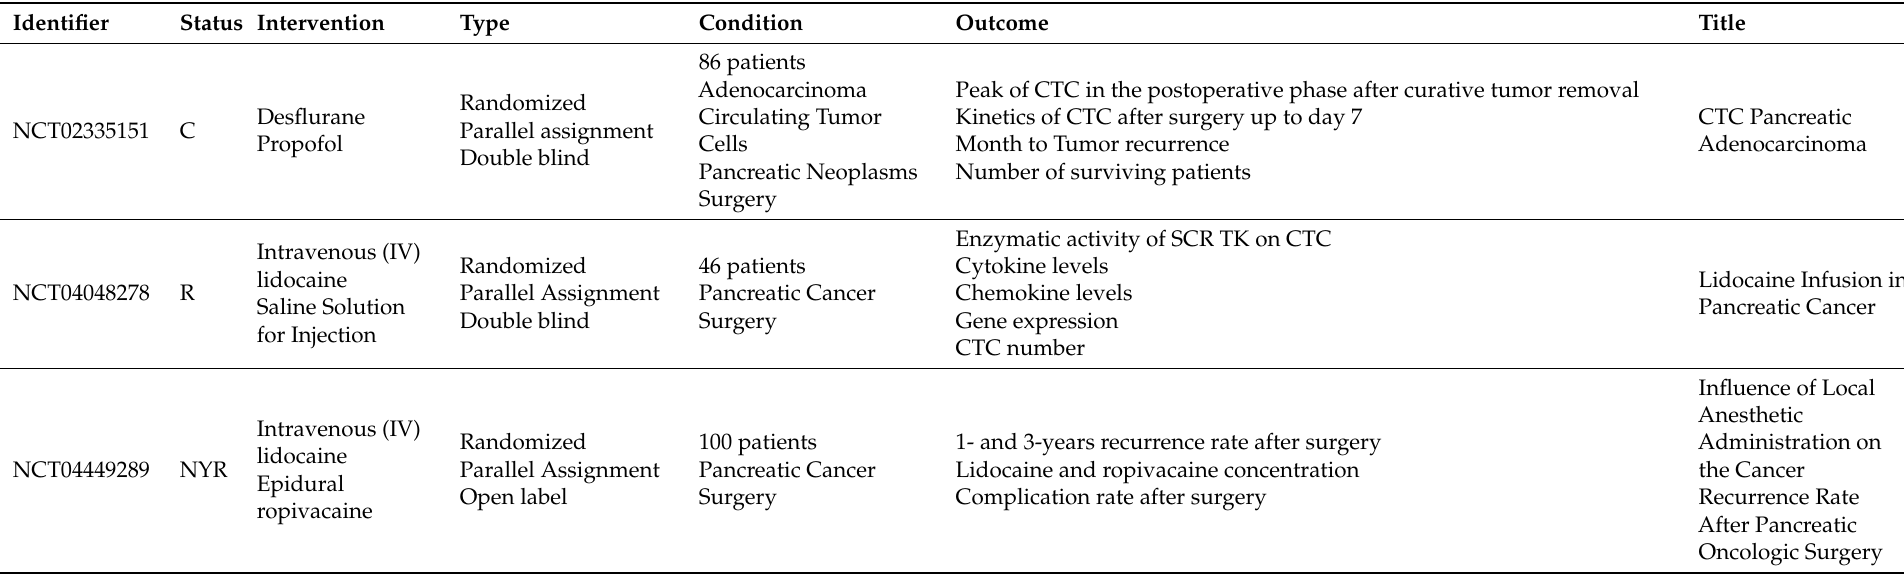
Table 1. Ongoing trials on pancreatic cancer and recurrence-related outcomes with repurposed